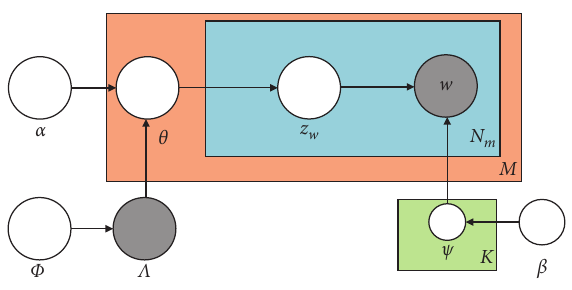
Figure 5: The graphical model of LLDA